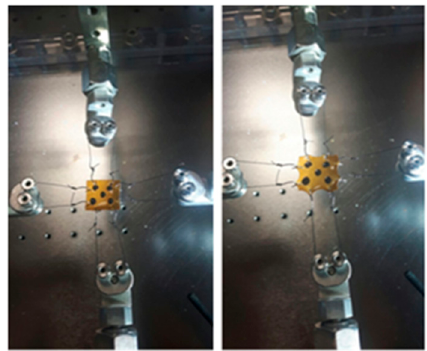
Figure 5. Experimental set up for biaxial test.